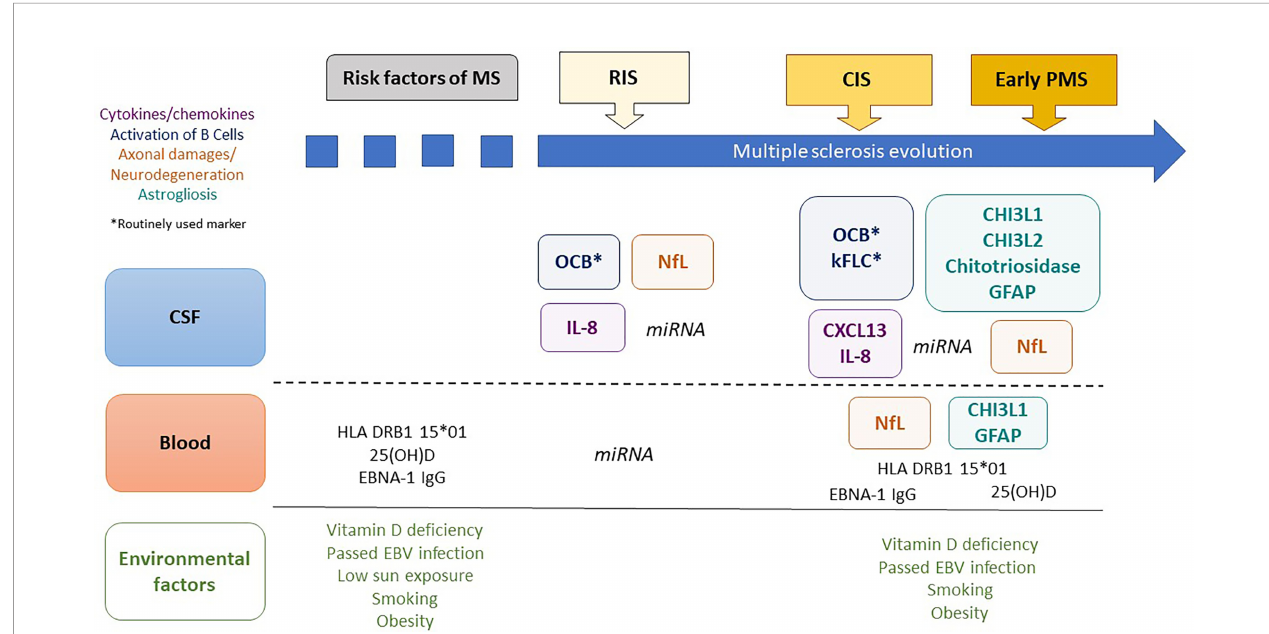
FIGURE 1 | Biological markers predictive of clinical evolution in early multiple sclerosis. MS, multiple sclerosis; CSF, cerebrospinal fl uid; RIS, radiologically isolated syndrome; CIS, clinically isolated syndrome; PMS, progressive MS; 25(OH)D, 25-hydroxy vitamin D; EBNA1-IgG, Epstein – Barr Virus-encoded nuclear antigen 1 speci fi c immunoglobulin G; OCBs, oligoclonal bands; CHI3L1, chitinase 3-like protein 1; CHI3L2, chitinase 3-like protein 2; GFAP, glial fi brillary acidic protein; NFL, neuro fi lament-light chain; kFLC, kappa Free Light Chains; miRNA,